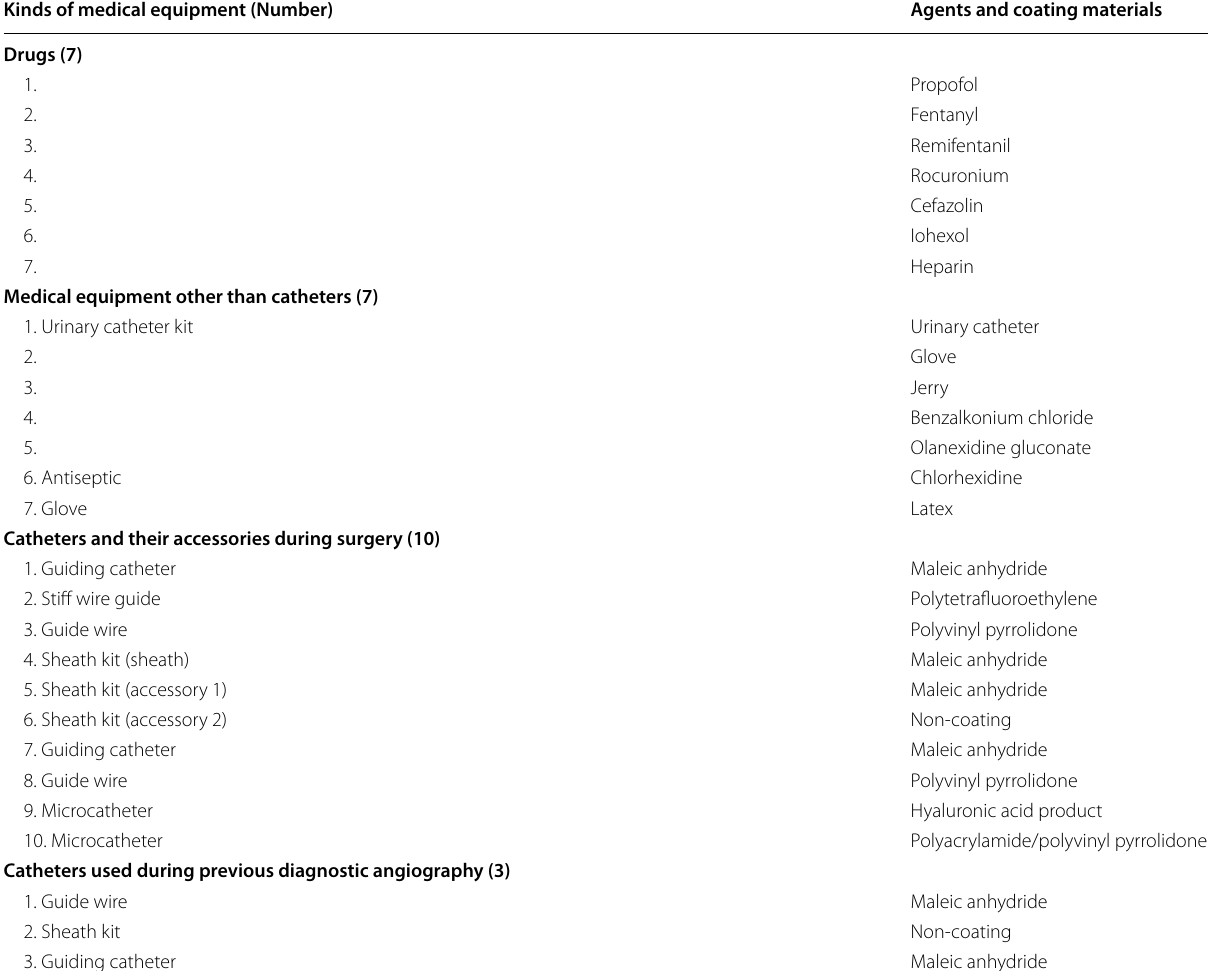
Table 1 Drugs and materials of medical equipment used during neuroendovascular surgery and previous diagnostic angiography Kinds of medical equipment